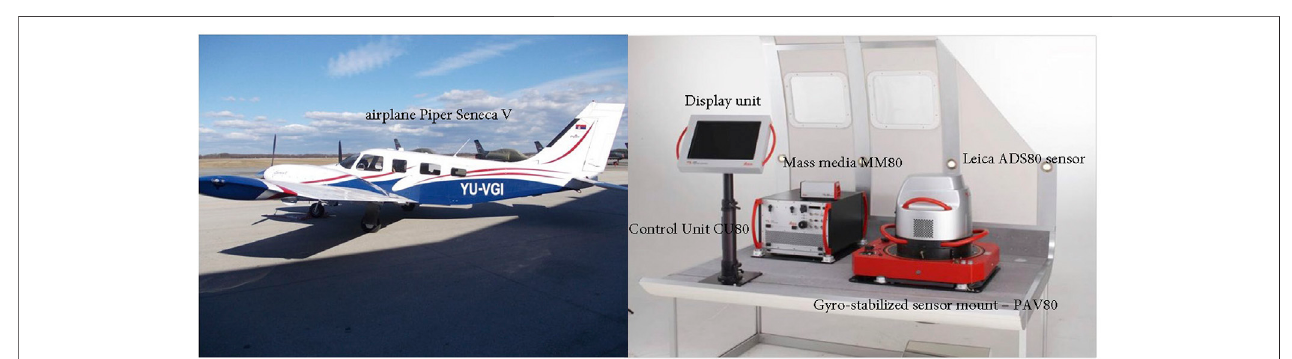
FIGURE 2 | Aerial photogrammetric recording